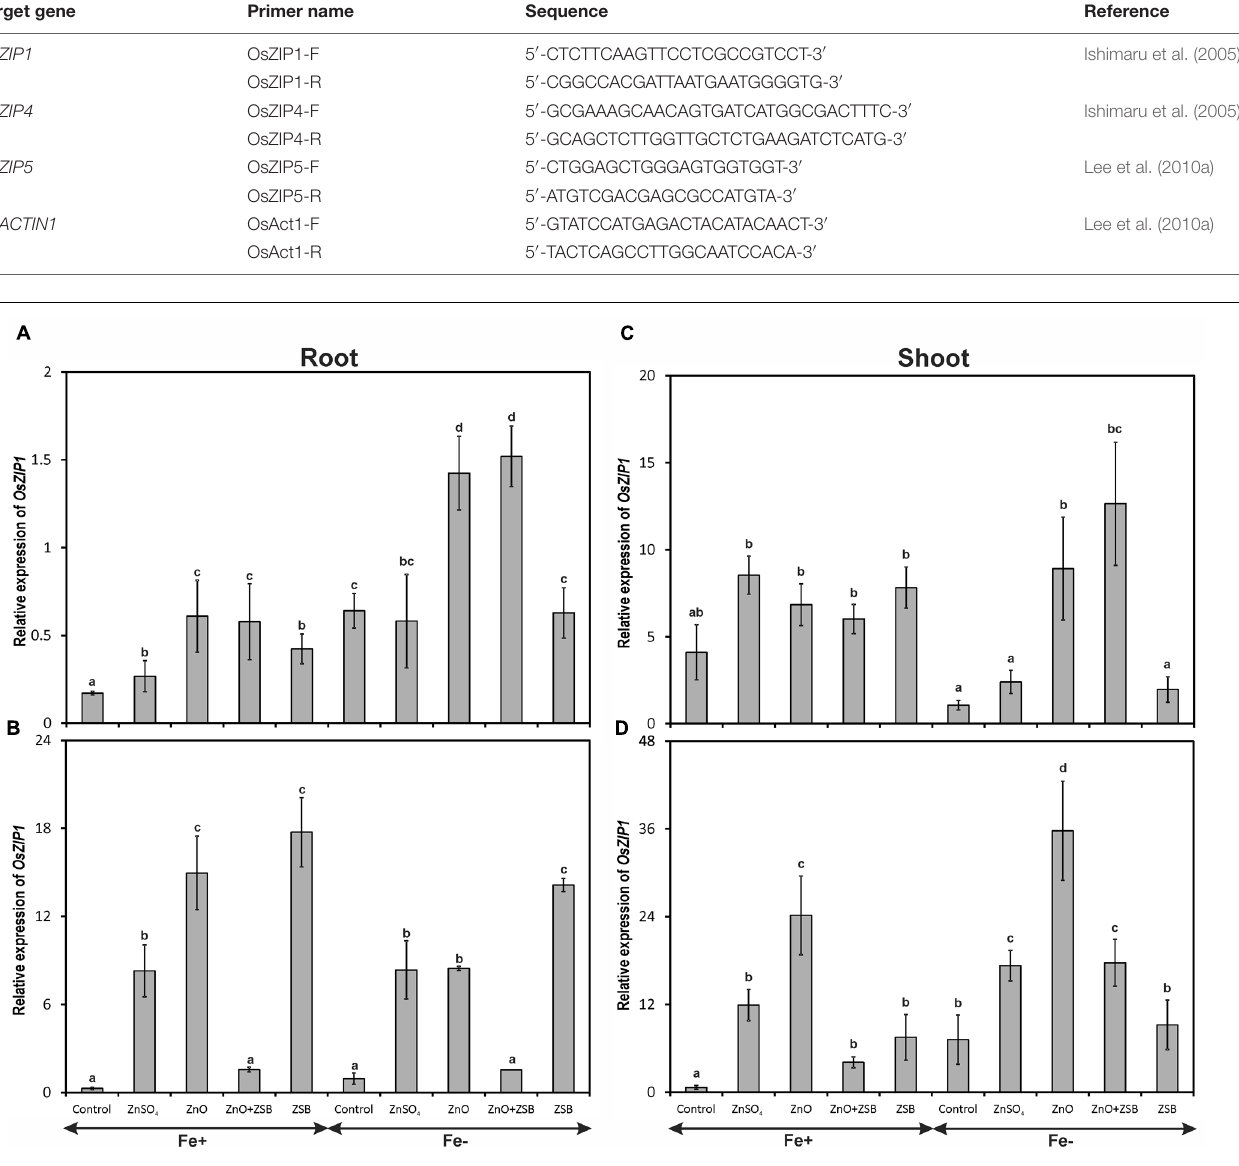
FIGURE 1 | Expression pattern of OsZIP1 in root (A,B) and shoot (C,D) of rice seedlings as influenced by Fe and Zn. (A,C) 7th day expression levels; (B,D) 14th day expression levels. Fe + , Fe sufficient condition; Fe − , Fe deficient condition. Control, No-zinc control; ZnSO 4 at 5 mM; ZnO at 10 mM; ZSB, Zinc solubilizing bacteria ( Enterobacter cloacae strain ZSB14) inoculation on 7th day. Relative mRNA abundance of OsZIP1 was quantified and normalized with OsACTIN1 gene on 7th day and 14th day. Data from real-time RT-PCR experiments were analyzed according to the 2 − (cid:49)(cid:49) Ct method. Means of six replicate values plotted, errors bars indicate the standard error. Values followed by the same letter in each panel are not significantly different from each other as determined by DMRT ( p ≤